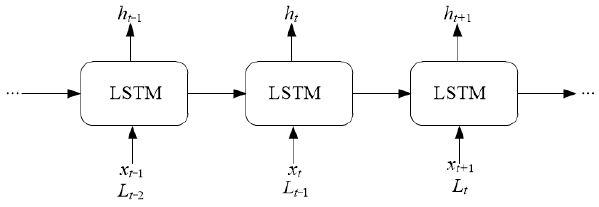
Figure 9. Second highest load rate prediction.